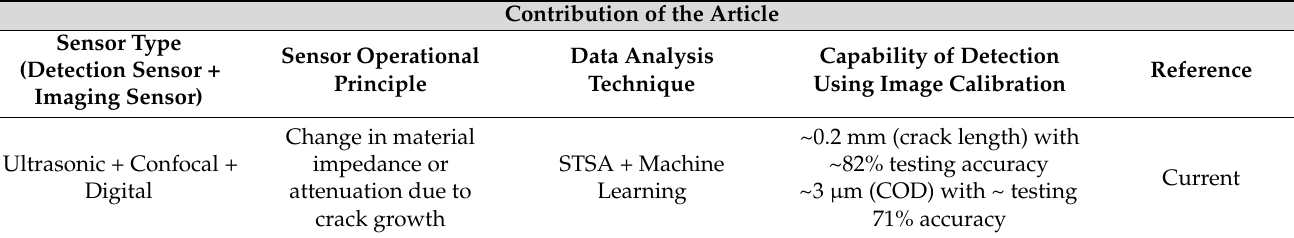
Table 2. The contributions of the current article with the methods described in Table